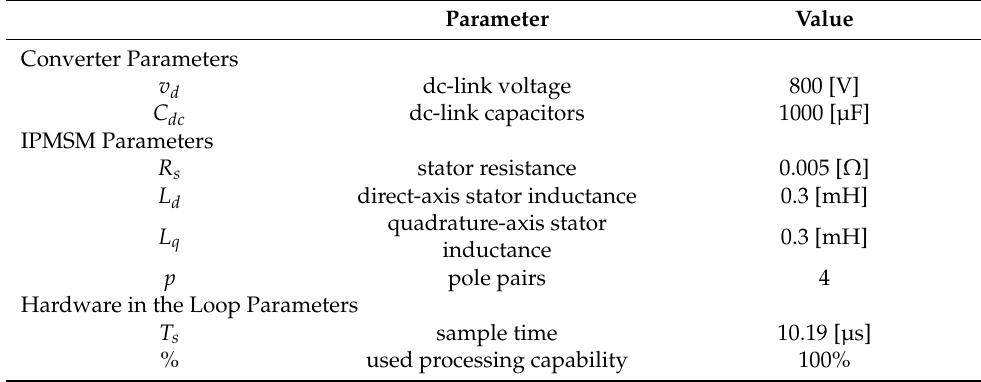
Table 2. HIL-simulation